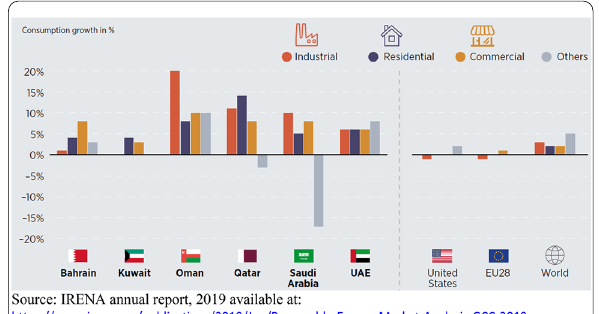
Fig. 1 Energy consumption by sector in GCC with comparative of USA, Europe, and the